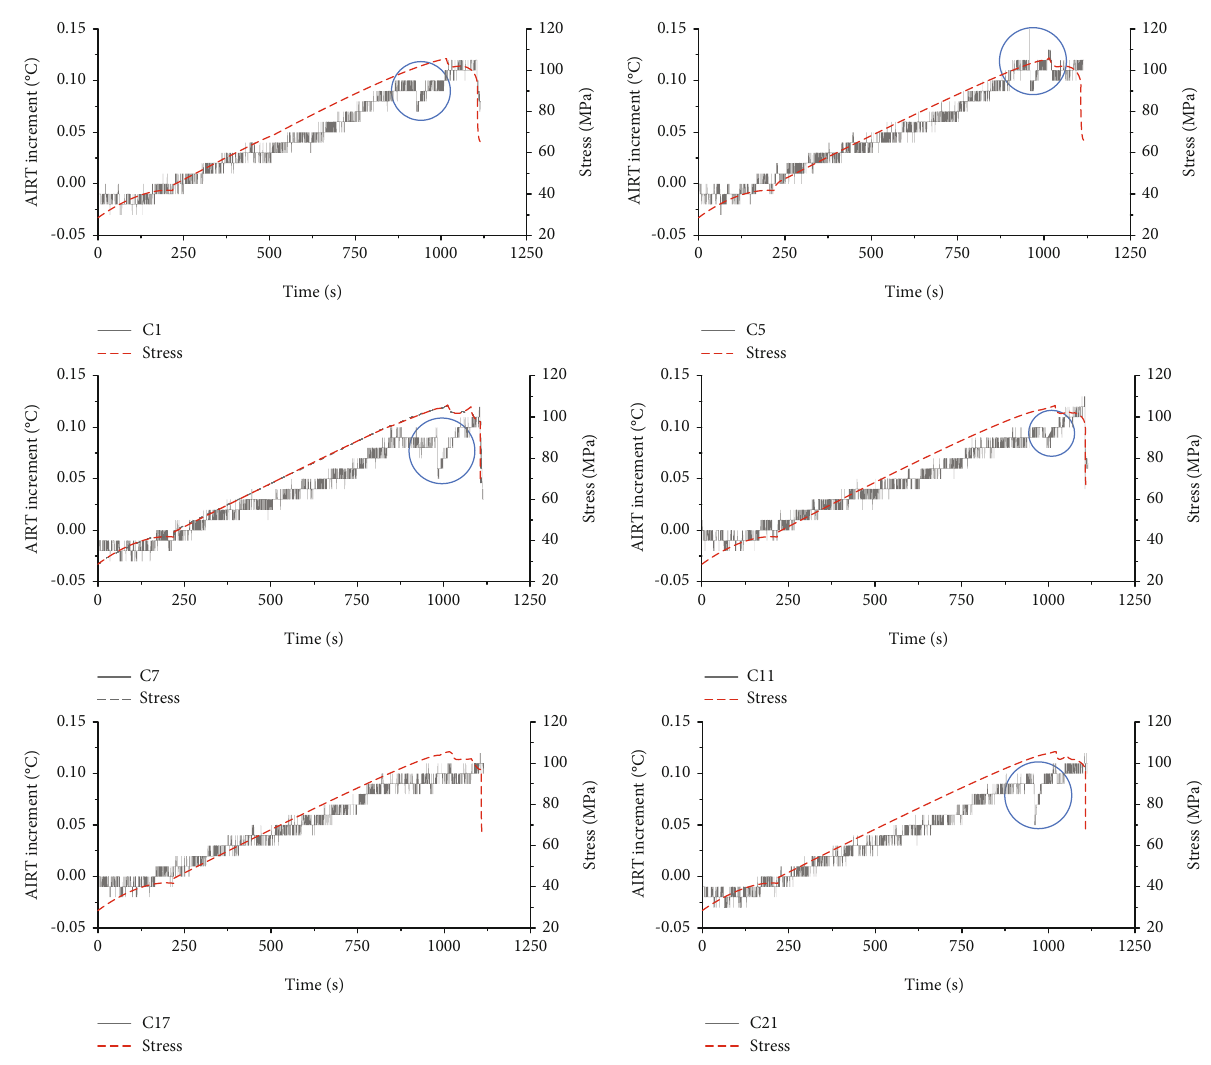
Figure 4: AIRT increment/stress-time under